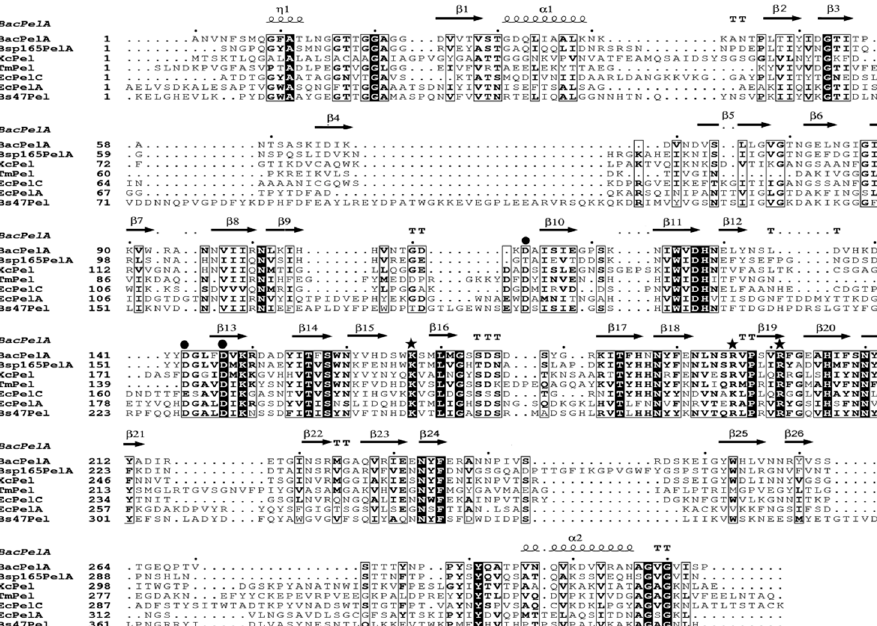
Figure 3. Multiple amino acid sequence alignment of crystalized PL1 pectate lyase. The pectate lyases used were BacPelA, Bsp165PelA from Bacillus sp. 16-5 (PDB 3VMV), XcPel from Xanthomonas campestris (PDB 2QX3), TmPel from Thermotoga maritima (PDB 3ZSC), EcPelA and EcPelC from Erwinia chrysanthemi (PDB 1PE9 and 2EWE), and Bs47Pel from Bacillus sp. TS-47 (PDB 1VBL). Strictly conserved residues are shaded black, and conservatively substituted residues are boxed. The secondary structural elements (helices- α , strands- β , turns-T, and helices- η ) of BacPelA are shown above the aligned sequences. The conserved catalytic sites and calcium binding sites are indicated by asterisks and circles, respectively. The figure was produced using ESPript 3.0 (http://es-